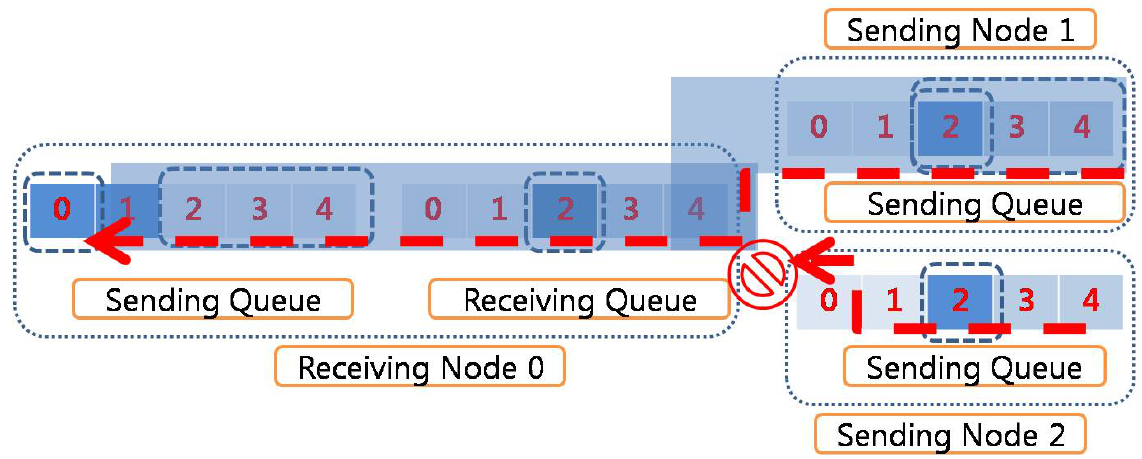
Figure 7. Preemption scheme. A sensor node possesses exclusively the parent node during the image